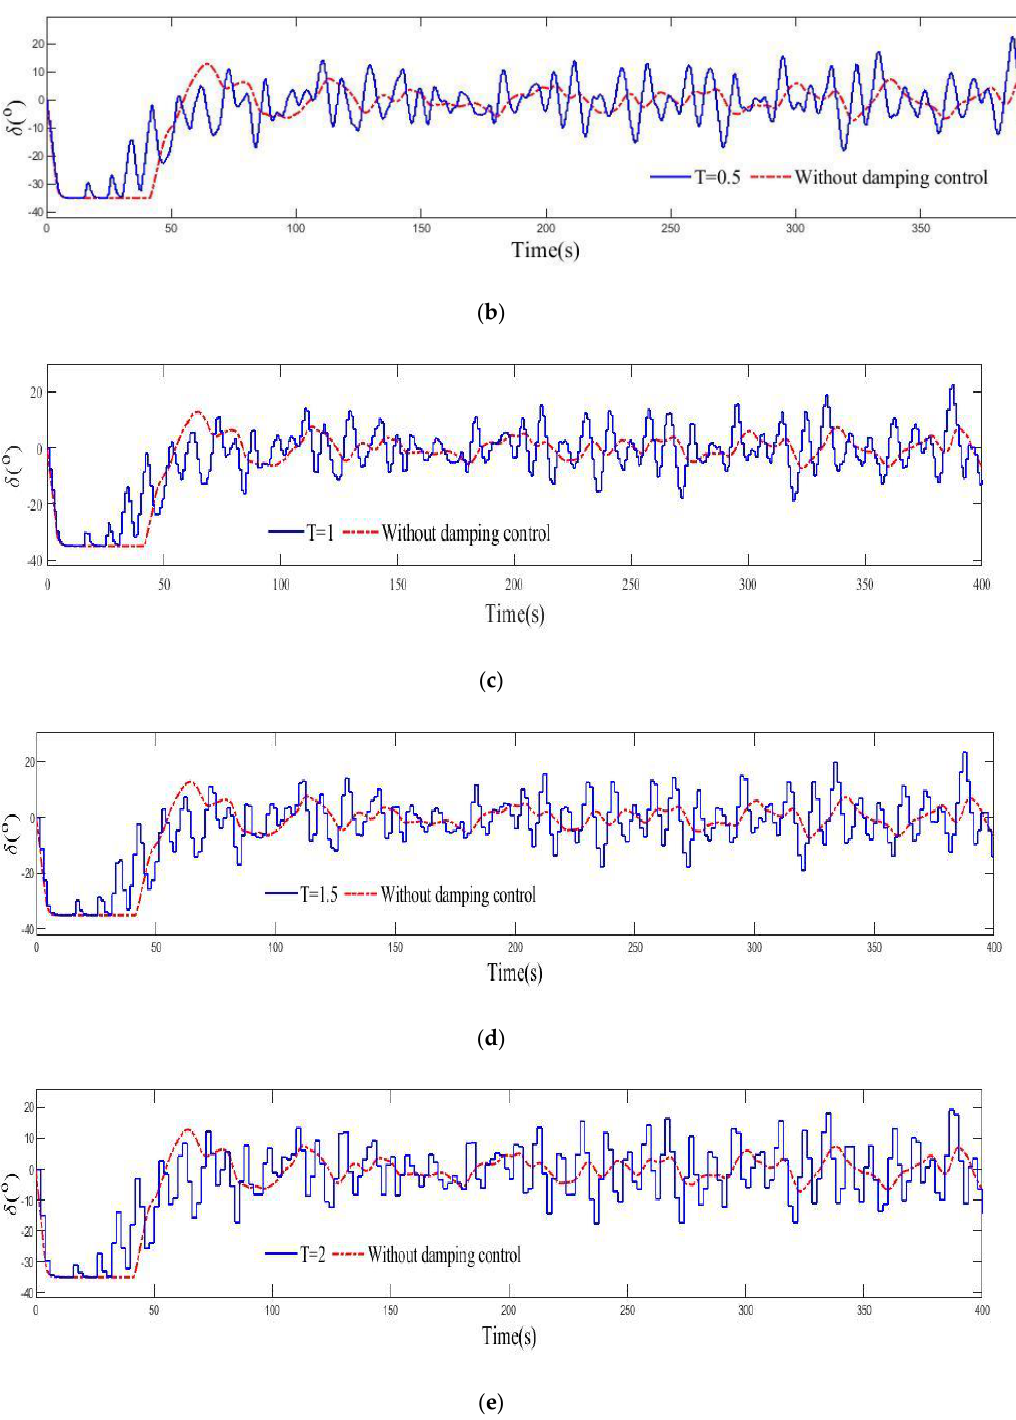
Figure 12. ( a ) Rudder angle when hold time is 0.3 s; ( b ) Rudder angle when hold time is 0.5 s; ( c ) Rudder angle when hold time is 1 s; ( d ) Rudder angle when hold time is 1.5 s; ( e ) Rudder angle when hold time is 2 s.